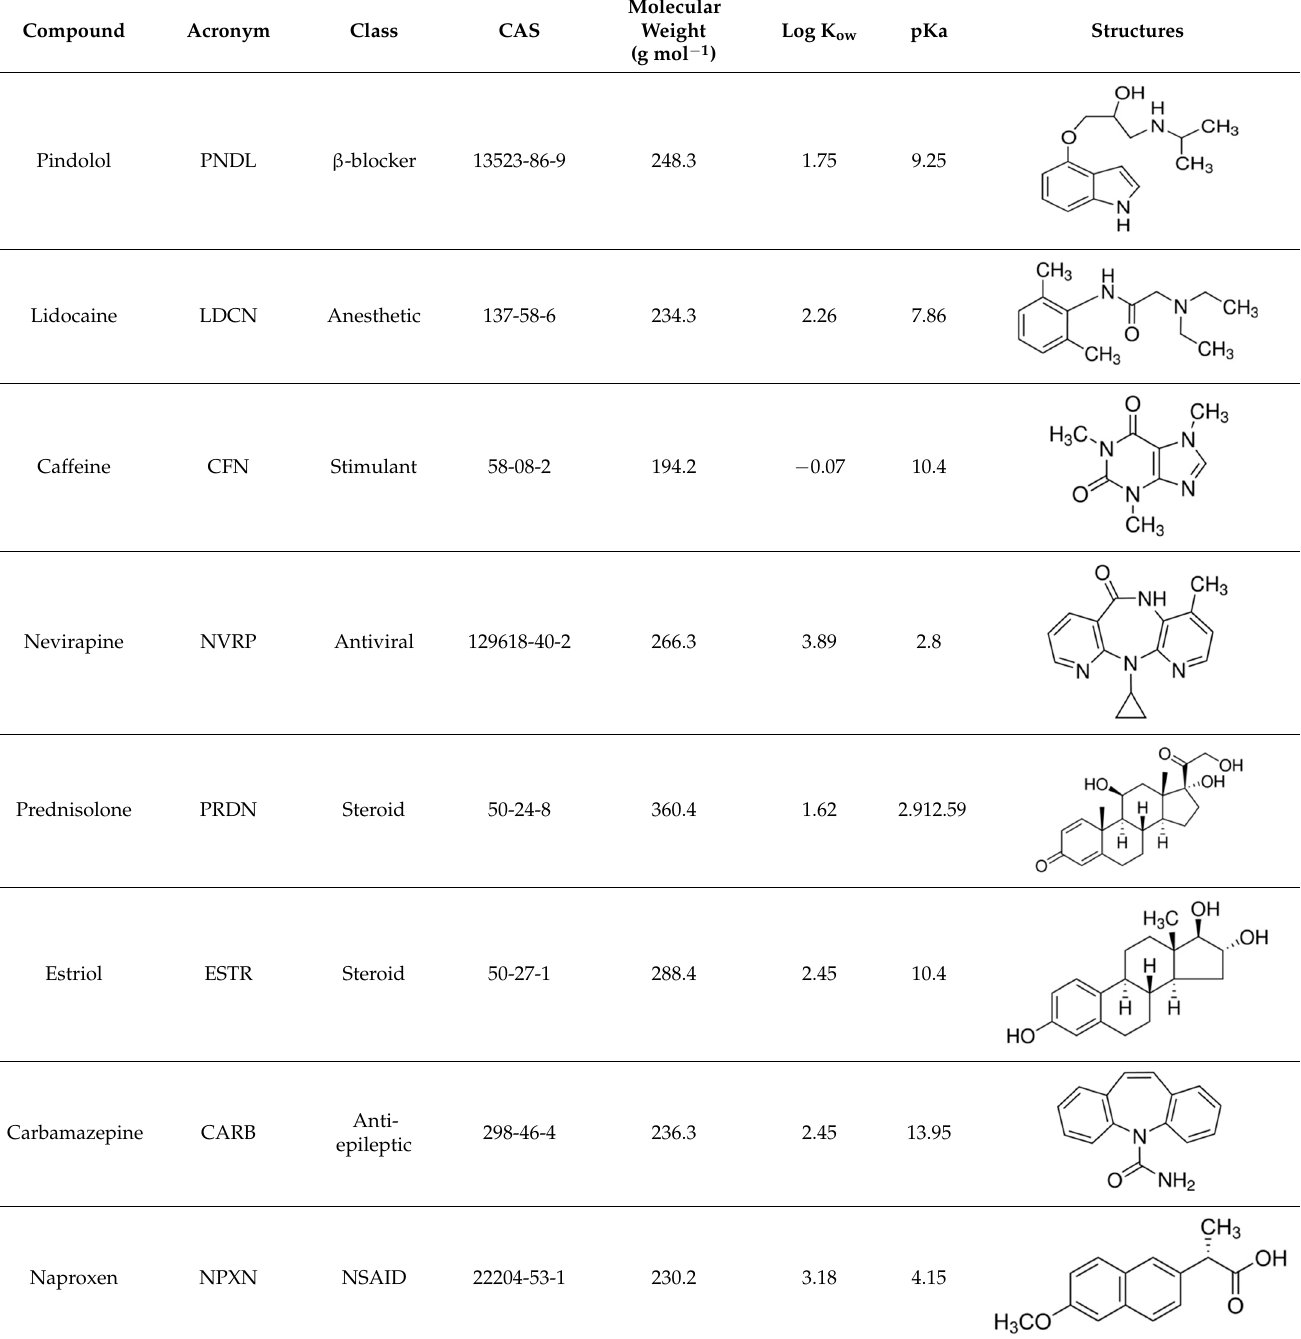
Table 1 . Physicochemical properties and structures of selected pharmaceutical drugs.